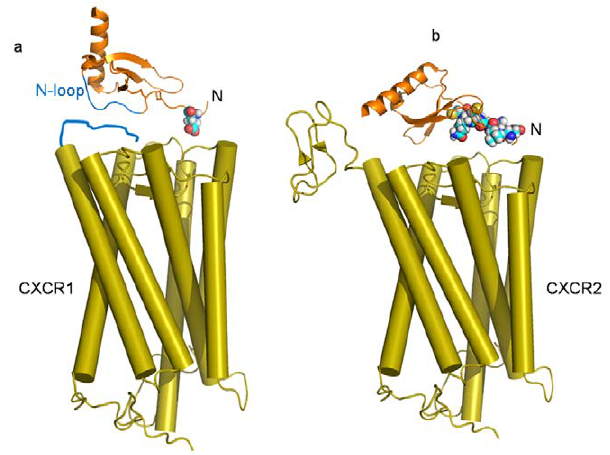
Figure 7. Models for the interaction of CXCL8 with CXCR1 and CXCR2. a. The N loop of CXCL8 (blue) binds to CXCR1 in site 1, which includes the N-terminus of CXCR1 (blue), the major determinant for the selective high affinity binding to CXCL8. Site 2 in CXCR1 binds Glu4 (sphere) of CXCL8 to trigger receptor activation. b . CXCR2 binds to the N-terminus of CXCL8 (Glu4, Arg6 and CXC are represented as spheres) to elicit receptor activation.